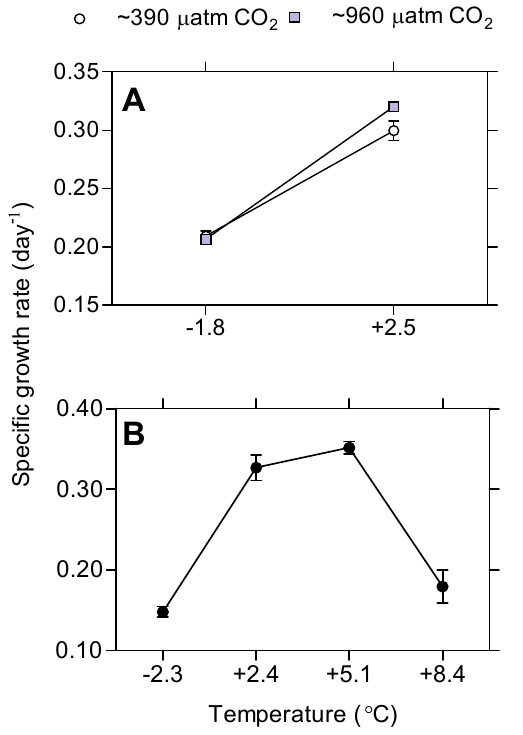
Fig. 1. Specific growth rate (day − 1 ) during 14 days of treatment. (A) Interaction of temperature and p CO 2 in Experiment A. ( n = 4) (B) Optimal growth temperature during Experiment B ( n = 5). Error bars are displaying standard error.